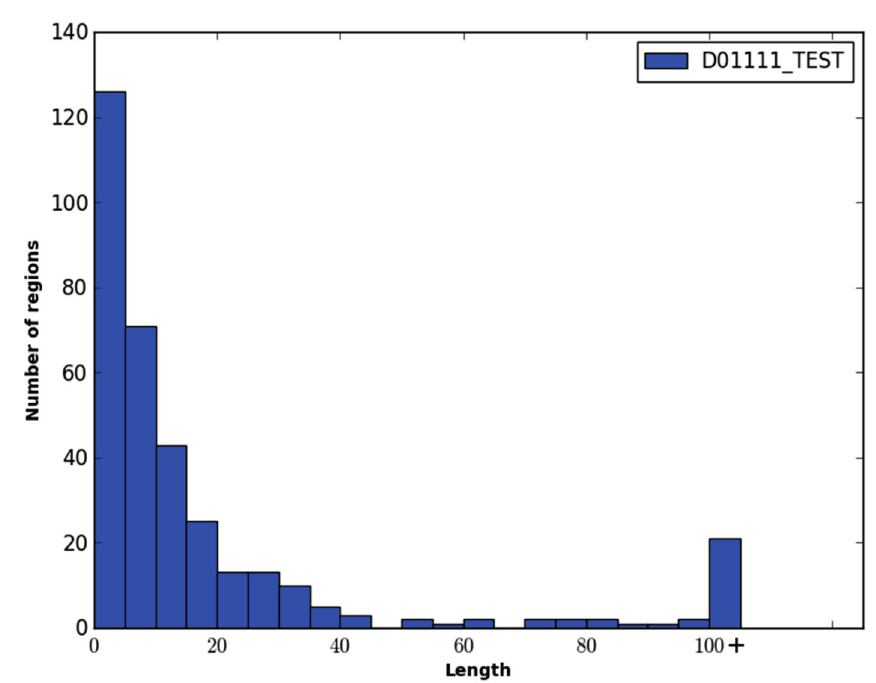
Figure 6. Distribution of the length of disordered regions in the DO1111_TEST dataset. Each bin represents a range of five residues, and the last bin represents the number of disordered regions that have a length greater than 100